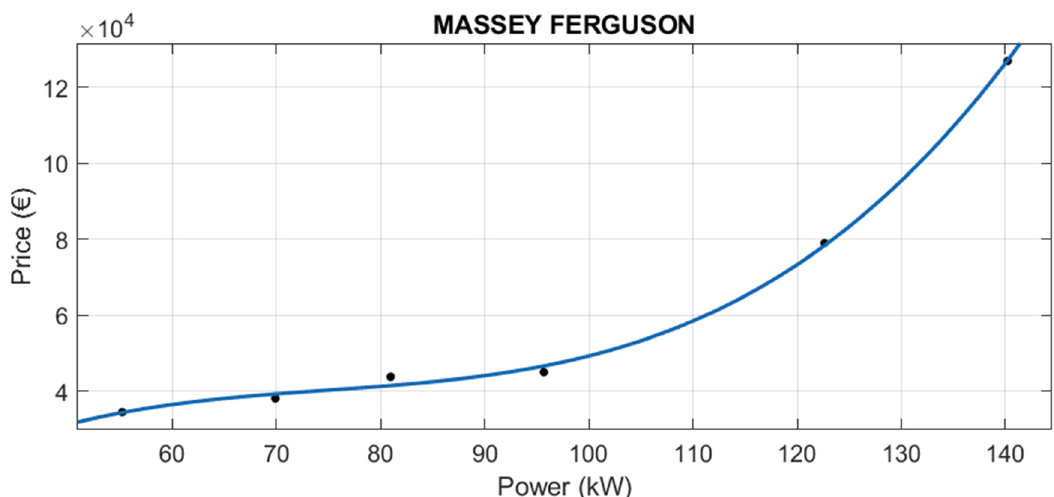
Figure 8. Price vs. power for John Deere new tractors.